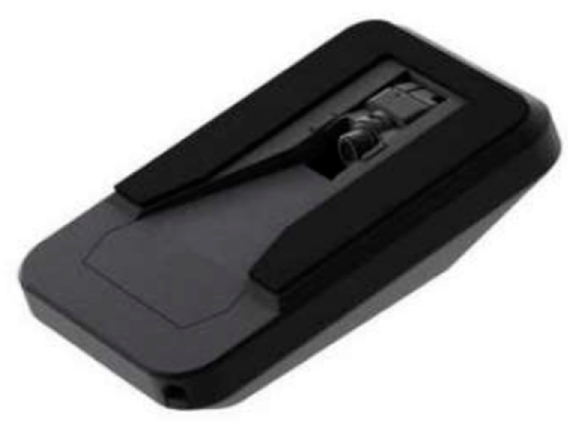
Figure 8. Intelligent mono-camera by Mobileye [154].